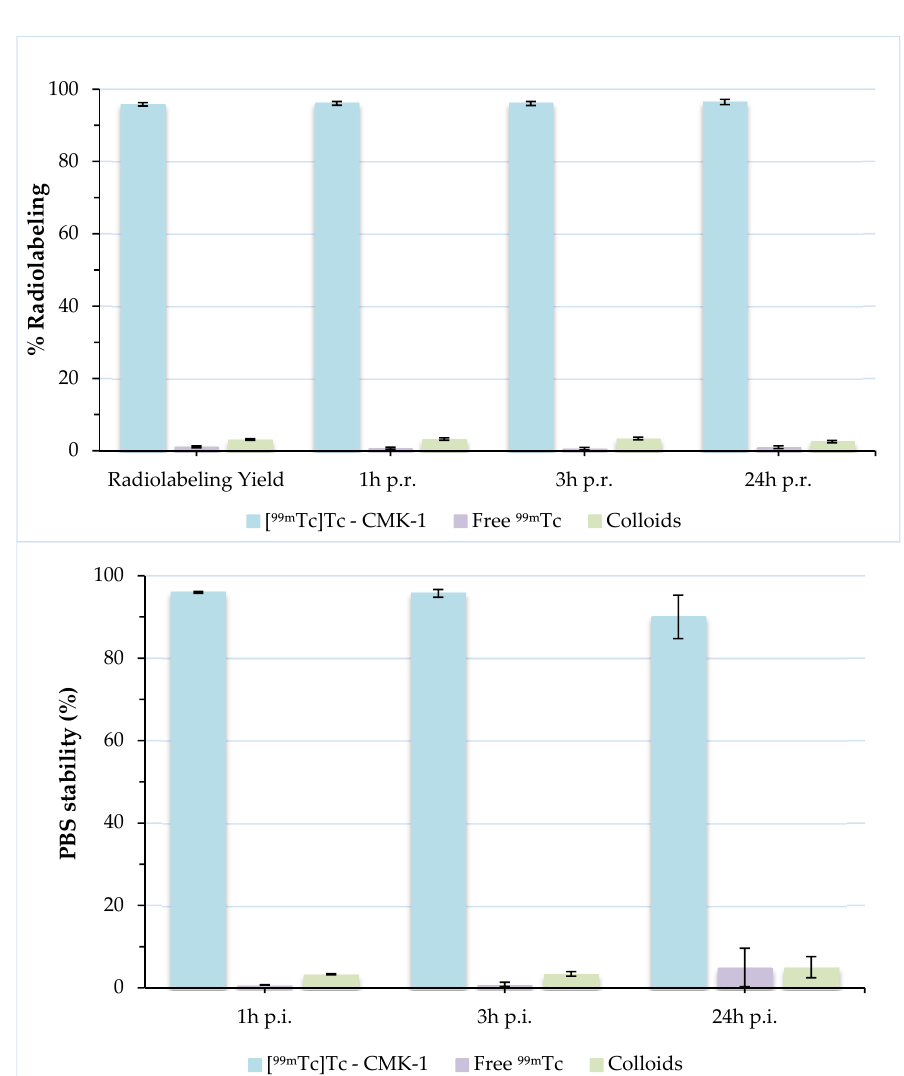
Figure 4. Radiochemical stability of [ 99m Tc]Tc-CMK-1 in the presence of PBS pH 7.4 up to 24 h post-incubation (p.i.).